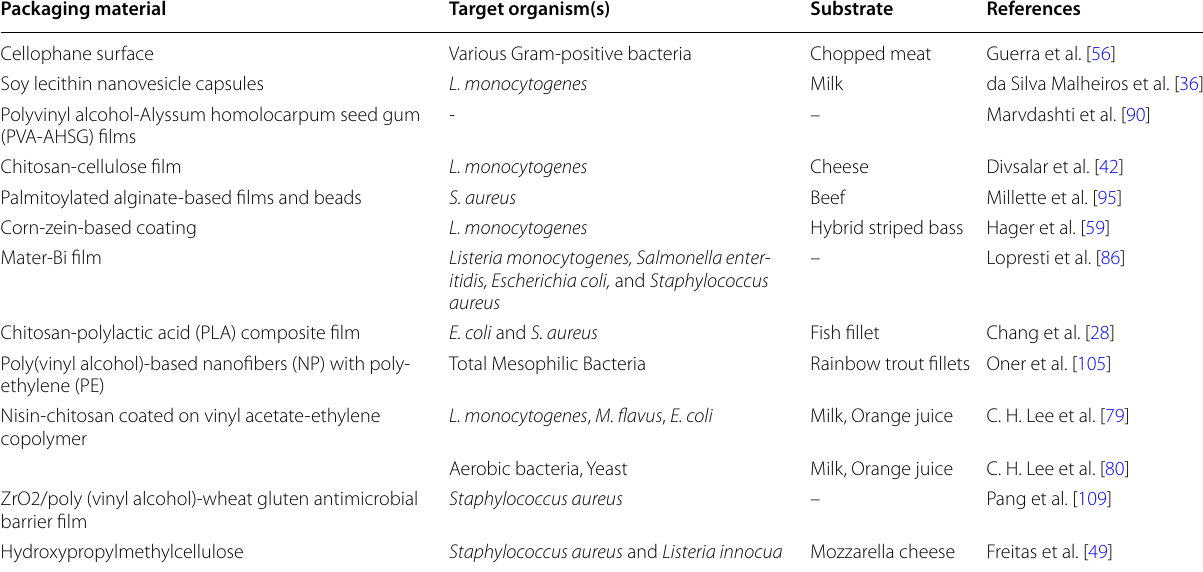
Table 4 Examples of the incorporation of nisin in the antimicrobial packaging of food products Packaging